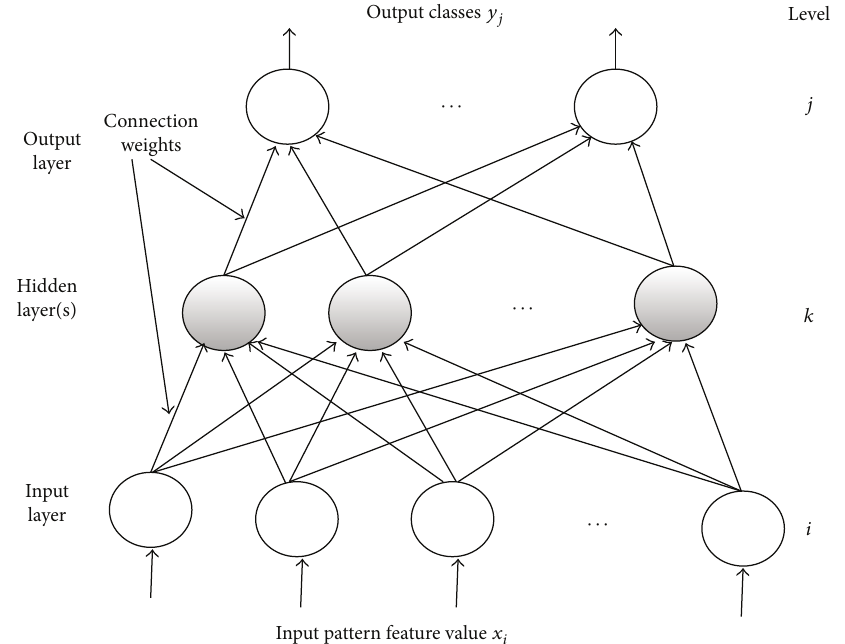
Figure 2: Structure of a multilayer perceptron